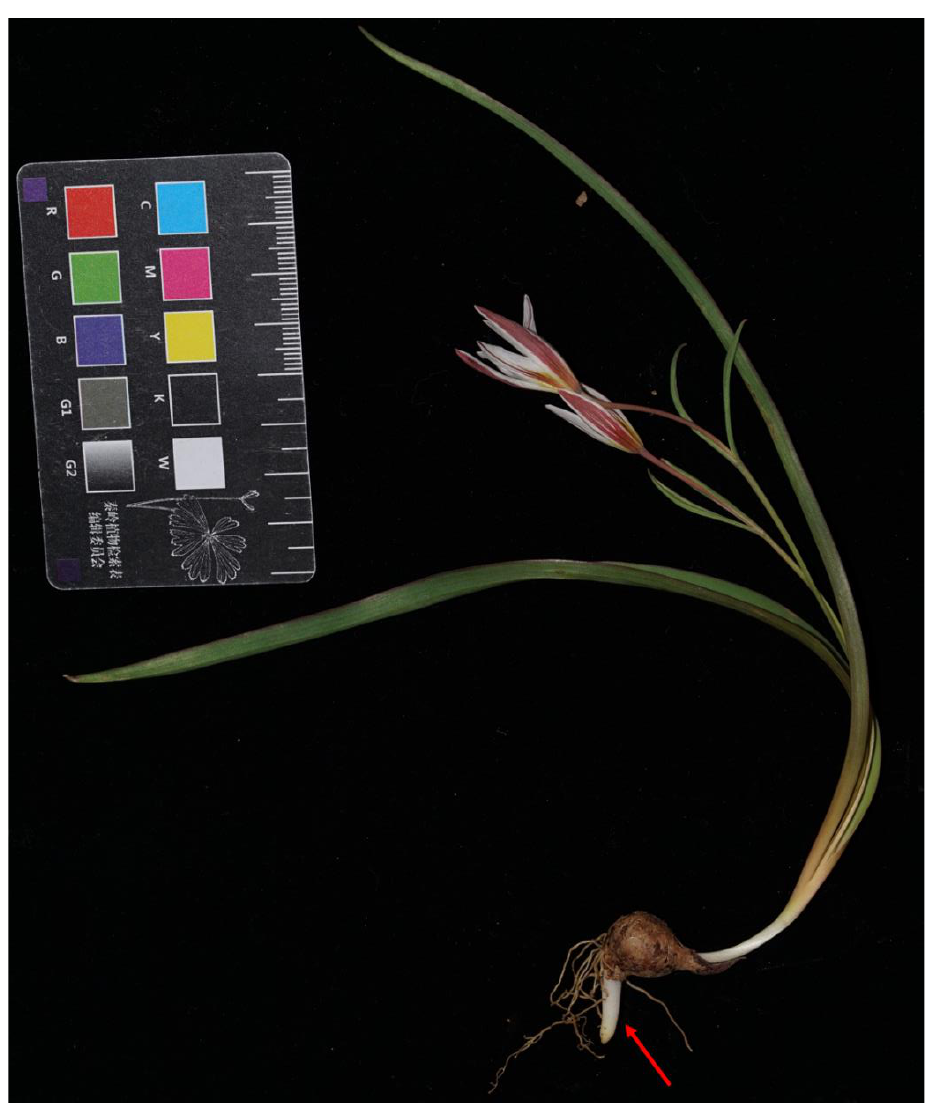
Figure A1. A whole plant of Amana edulis . The red arrow points to the vertical dropper.